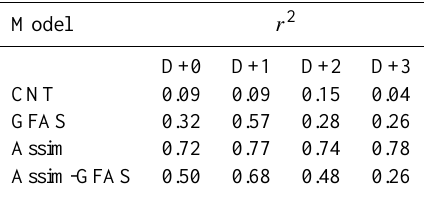
Table 5. Temporal correlation of modeled AOD compared to the measurements from AERONET station at Moscow, between 20 July and 15 August ( n = 27), as function of the hindcast